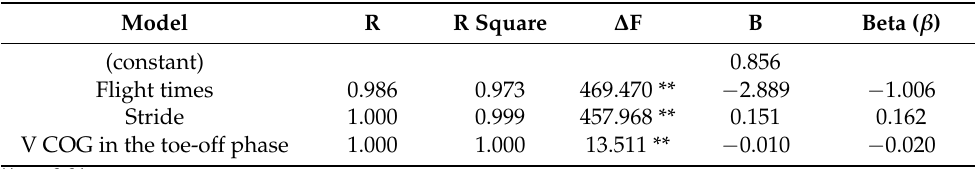
Table 4. Multiple linear regressions for